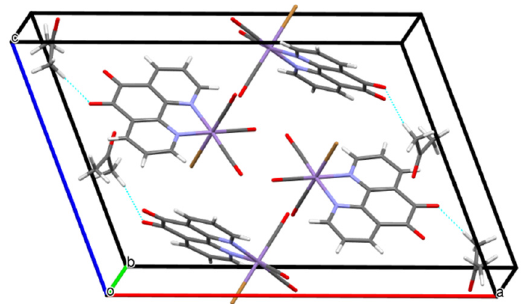
Figure 4. Crystal packing of [MnBr(CO) 3 (dpq)] · (CH 3 ) 2 CO with C–H ... O hydrogen bonds indicated by blue dashed lines.